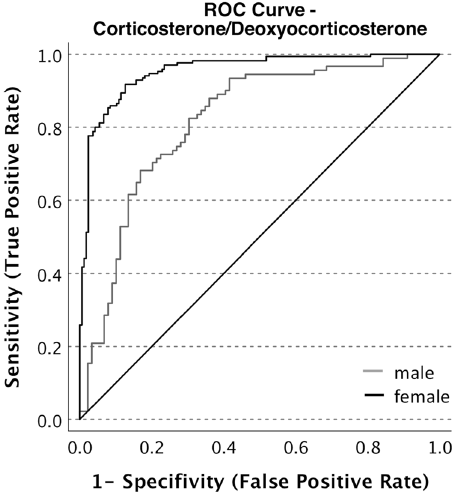
Fig. 3 ROC curves for corticosterone/deoxycorticosterone. Results are separately displayed for males and